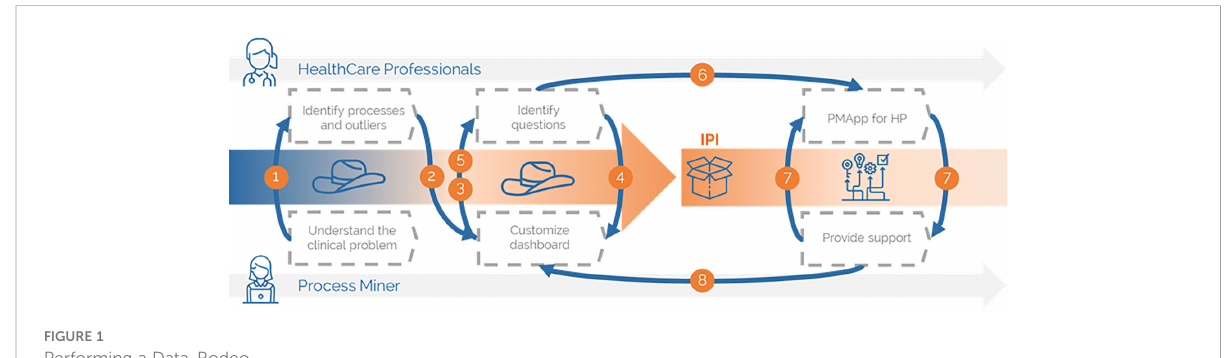
FIGURE 1 Performing a